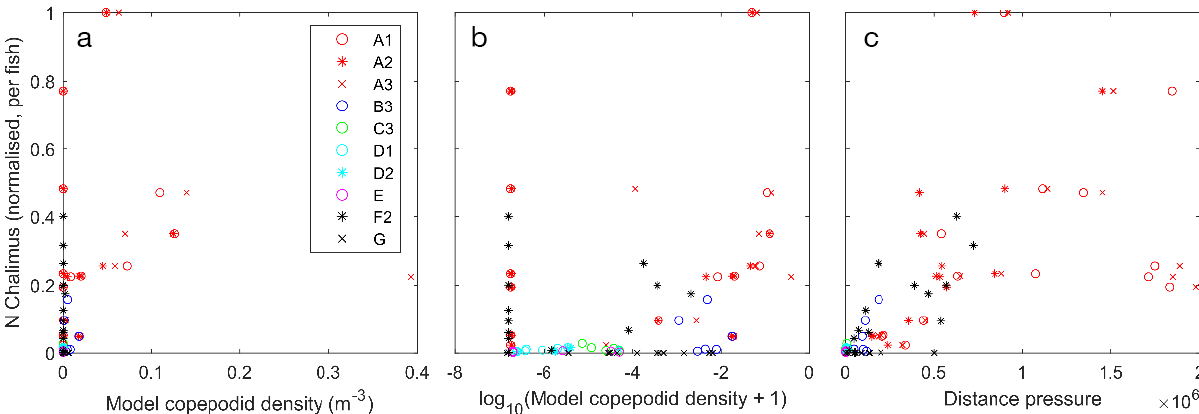
Fig. 8. Model outputs versus normalised site chalimus (juvenile attached Lepeophtheirus salmonis ; N chalimus) counts. Each data point relates to a specific site (numbered within each geographical grouping) and week. (a) Biophysical model prediction of copepodid (infective lice) density. (b) Log transformed (+1) biophysical model prediction. (c) Distance- weighted density prediction with 1 wk delay. Site counts of chalimus ( y -axis) are normalised by maximum total chalimus count for any farm over the study